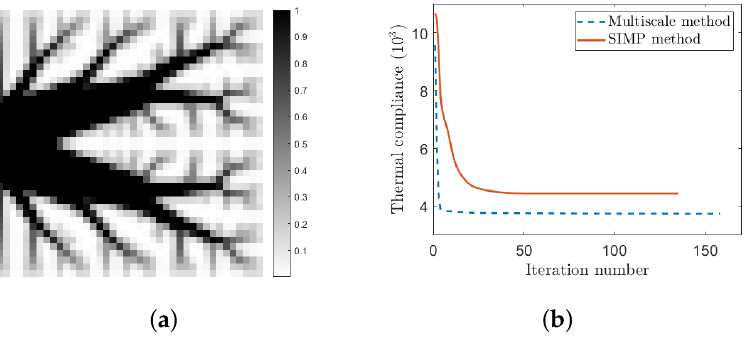
Figure 7. Optimization results and convergence history: ( a ) the relative density distribution obtained by the SIMP method; ( b ) iteration history for the SIMP method and the multiscale